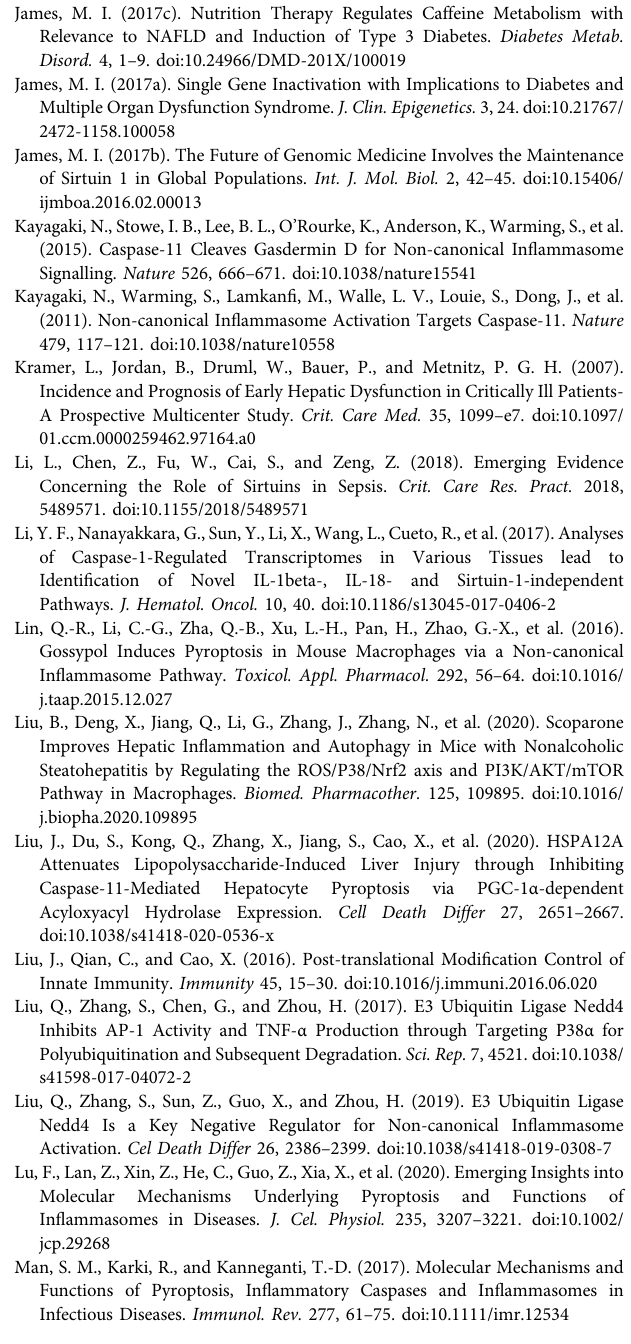
were counter stained with DAPI. The staining was observed using a fl uorescence microscope. (D) LPS abundance in RAW264.7 cells was indicated by the FITC fl uorescence intensity that measured by a fl uorescence microplate reader at excitation/emissionwavelengthsof490/530 nm;*P < 0.05,**P < 0.01,***P < 0.005. Supplementary Figure 2 | Different concentrations of samotolisib improved pathological liver injury induced by LPS. (A) Plasma levels of AST and. (B) and ALT. Supplementary Figure 3 | Samotolisib cannot regulate autophagy and Sirtuin 1 in acute liver injury. (A) Western blotting showing the protein levels of Beclin-1, ATG5, P62, LC3. (B) Western blotting showing the protein levels of Sirtuin